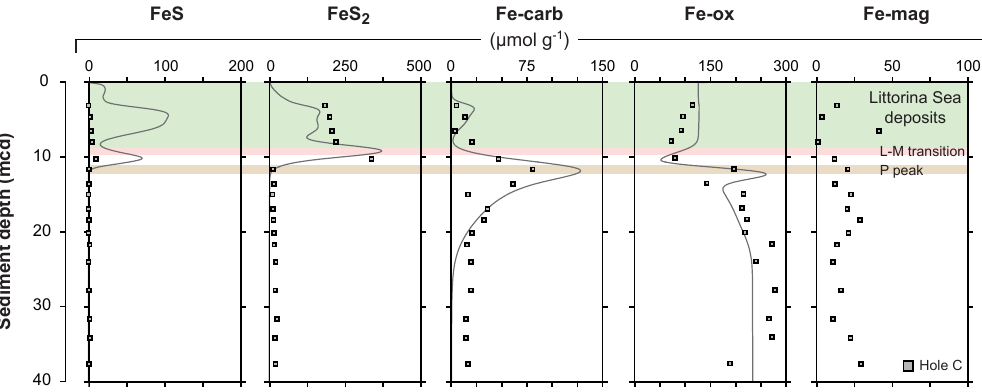
Figure 5. Trends in S and Fe phases with sediment depth for hole C. The S phases were extracted according to the procedure of Burton et al. (2008). Solid grey lines illustrate profiles derived from the diagenetic model. The Fe extraction of Poulton and Canfield (2005) was applied to determine Fe carbonates (Fe-carb), sedimentary Fe oxides (Fe-ox; sum of amorphous and more crystalline Fe oxides) and magnetite (Fe- mag). Details on the colored areas can be found in the legend of Fig.